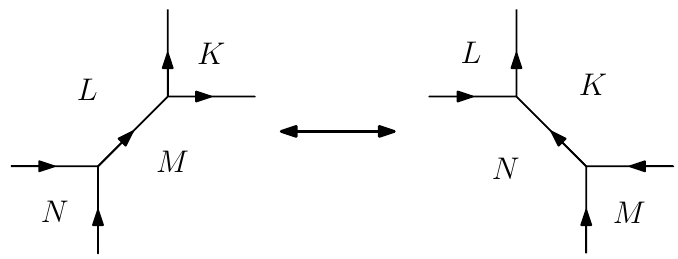
Figure 16. Flip transition for type 1 j 1 (resolved conifold)